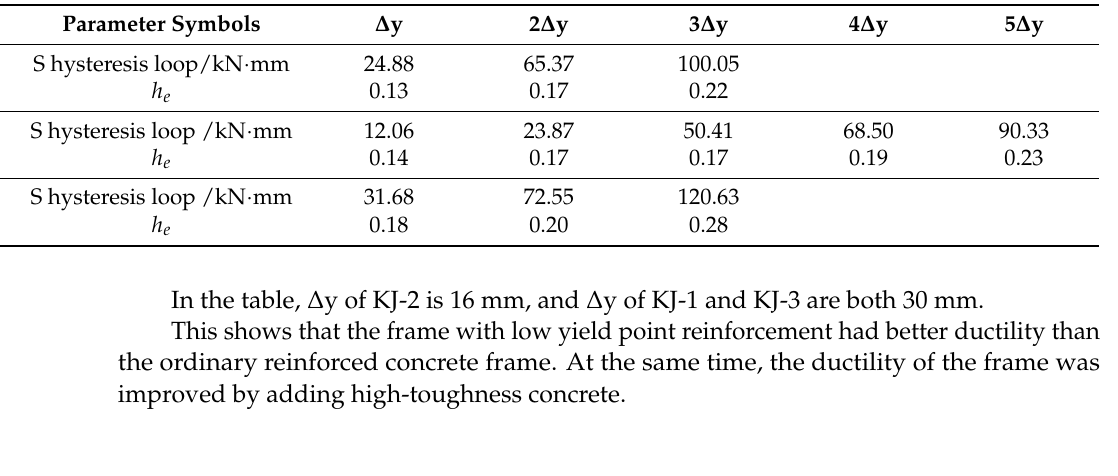
Table 5. Displacement versus equivalent he.